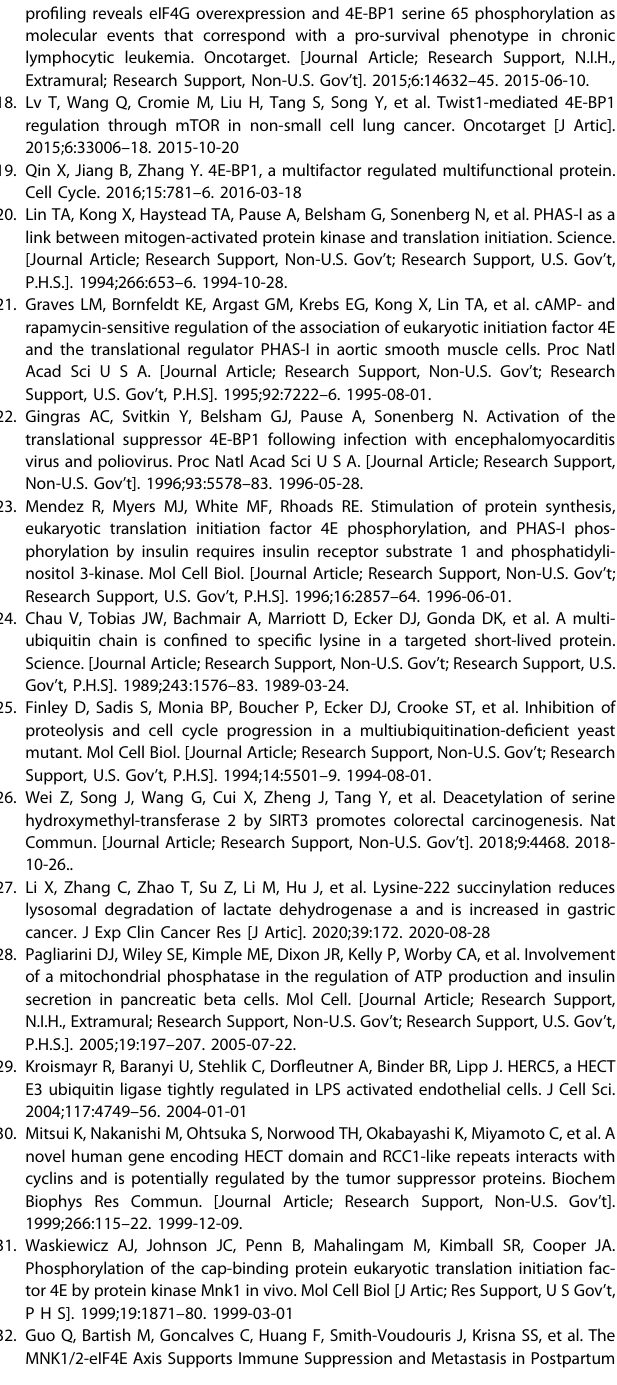
Fig. 6 4EBP1 inhibits tumor progression under glucose deprivation conditions in vivo. A Western blot analysis of 4EBP1 expression in parental A549 and A549-sh4EBP1 cells. B Parental A549 and A549-sh4EBP1 cells were treated with normal or glucose starvation for 48 h. Cell growth rate was assessed by MTT assay. The data represent the averages of three independent experiments (mean ± SD). * P < 0.05. C Parental A549 and A549-sh4EBP1 cells were treated with normal or glucose starvation for 16 h. The changes of cell morphological was investigated (scale bar = 100 µm, magni fi cation: ×100). D Parental A549 and A549-sh4EBP1 cells were treated with normal or glucose starvation for 20 h. Cell apoptosis analysis was done by fl ow cytometry. E , F In vivo xenograft assay was performed using parental A549 and A549-sh4EBP1 cells, tumors were photographed ( E ), and their weights and volumes were measured ( F ). The P value was calculated by paired t -test. * P < 0.05. G Immunohistochemical staining in the tumor-central region of tumor induced by parental A549 and A549-sh4EBP1 cells for 4EBP1, p-STAT3, BCL2, MCL1, Survivin and Cleaved PARP1 (C-PARP1). Scale bars: 50 μ m, magni fi cation: